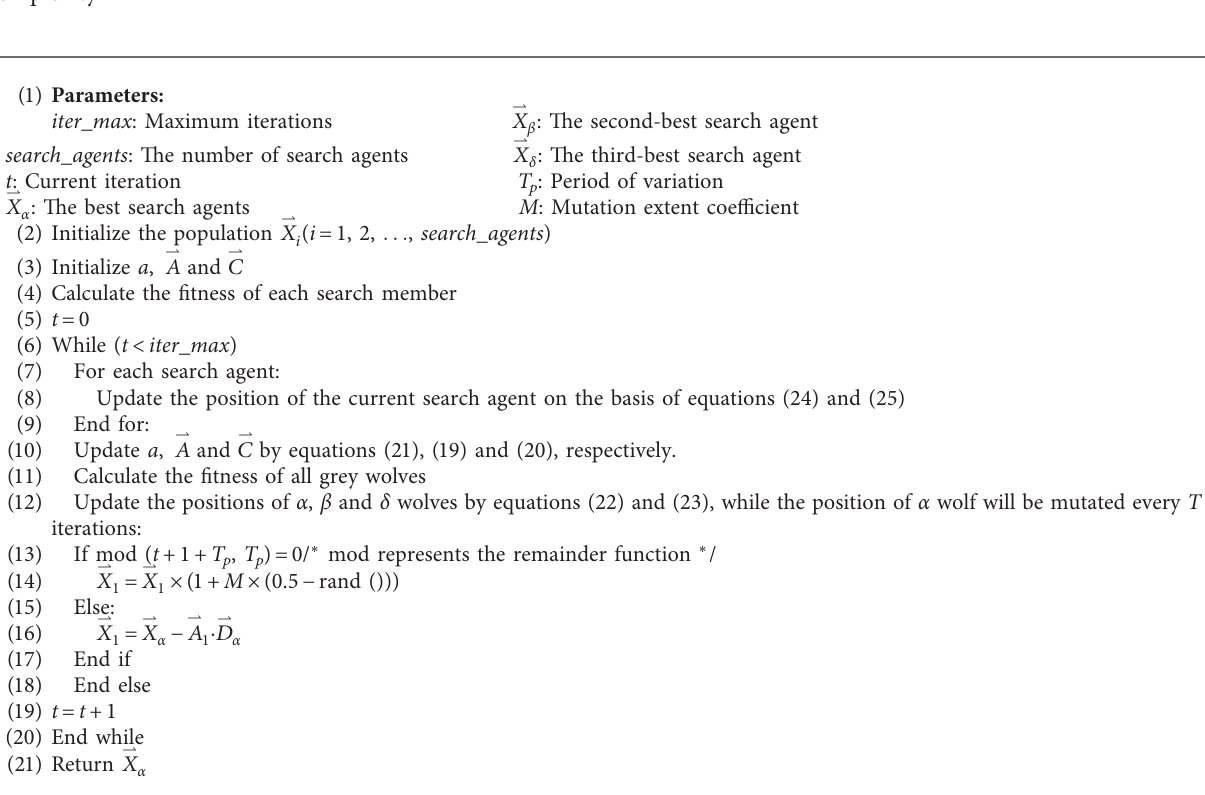
A LGORITHM 1: The pseudocode of the proposed AMGWO algorithm.